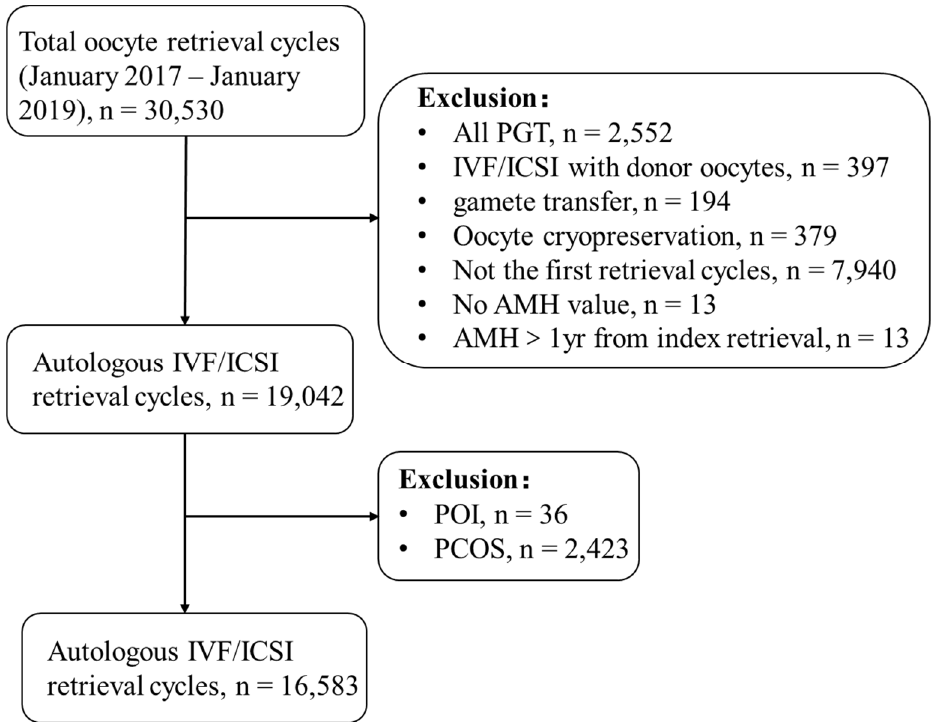
Figure 1. Flow chart of the study population. PGT: preimplantation genetic testing; IVF: in vitro fertilization; ICSI: intracytoplasmic sperm injection; AMH: anti-Müllerian hormone; POI: premature ovarian insufficiency; PCOS: polycystic ovary